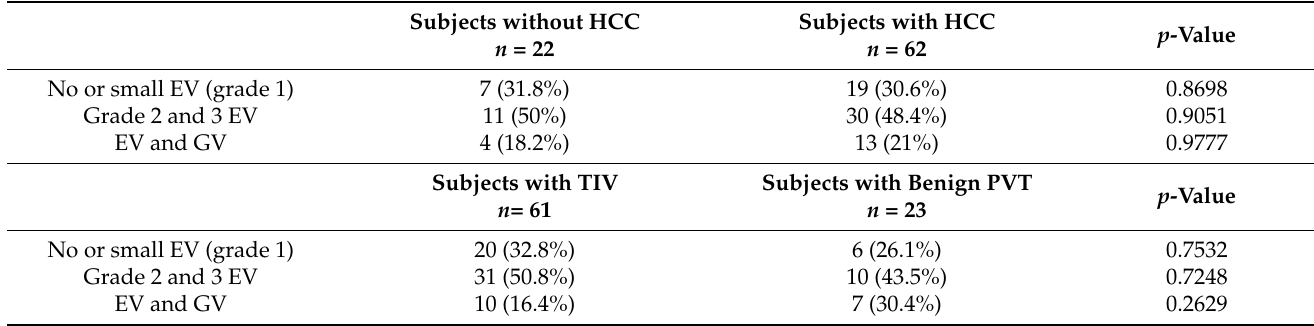
Table 2. The distribution of subjects according to the presence of endoscopic signs of portal hypertension.